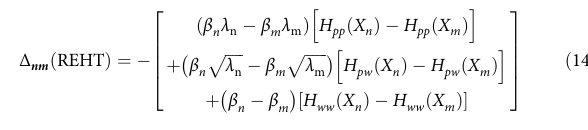
List of systems studied and preparation of atomistic model . Figure 1 and Supplementary Table 1 contain information about the diverse sets of proteins used in this work. The initial unfolded structure of Trp-Cage and β -hairpin (C terminal hairpin of B1 domain in protein G) were obtained by simulating the corresponding folded NMR structures (PDB ID: 1l2Y and 1lE3, respectively) at 600K temperature for 10ns. For His-5, the unfolded structure was built using VMD protein builder by feeding in the sequence information (DSHAKRHHGYKRKFHEKHHSHRGY). Simulation of RFA-H C-terminal domain was initiated from the α -helical conformation (PDB ID:2OUG). All the proteins (system 1 – 5 in Fig. 1) were solvated in a cubic box with a minimum distance of 1.2nm from the surface of the protein (in case of RFA-H 1.5nm is used). A 3-site rigid TIP3P water model was used for all the systems. The systems were also neutralized with physiological concentration of NaCl (0.15M). For the topological parameters of fast-folding proteins, we used Amberff14SB in order to faithfully compare the ef fi ciency with earlier REST2 and gREST simulations 16 , whereas for all the rest of the systems (alanine dipeptide, His-5 and RFA-H), Charmm36m 29 force fi eld was used. Details of MD simulation . The modeled proteins solutions were initially energy minimized using steepest descent algorithm for 50,000 steps to avoid any poor contacts. The minimized structure was then thermalized and equilibrated sequentially in NVT and NPT ensembles each for 2ns. The protein and the solvent were coupled separately to the target temperatures using a modi fi ed Berendsen thermostat. The pressure was set at 1bar using Parrinello-Rahman barostat. The fi nal production simulation was performed in NVT ensemble using Nose-Hoover thermostat. A cut-off of 1nm was used for calculating the electrostatics and VdW interactions. Particle Mesh Ewald was used for long-range electrostatics. Leap-frog integrator with a time step of 2fs was used to integrate the equations of motions. All the hydrogen atoms were constrained using LINCS algorithm. The simulations were performed using Gromacs-2016.5 patched with Plumed-2.4.1. All the para- meter fi les are available in the GitHub repository (https://doi.org/10.5281/ zenodo.4361714) 67 . Replica exchange parameters . For all the simulations, we ran both the REHT scheme designed in this work as well as the state-of-the-art REST2 method. The two methods differ in the way the protein and water molecules are treated in the Hamiltonian. REST2 tempers only the protein but keeps the water at room tem- perature by scaling the potential energy function of solute. The bath temperature used in REST2 is constant across all the replicas. On the other hand in REHT method, the bath temperature is raised mildly up to 340 K as we go up on the replica ladder. This suf fi ciently heats up the water molecules allowing for its ef fi - cient dynamics in REHT method. For enhancing the protein dynamics, the potentials of the protein solute are scaled up to a maximum factor ( λ ) of ~0.5. To ensure the faithful comparison, the overall effective temperature realized on the protein is identical in both the simulations (Supplementary Table 1). However, due to the extra degrees of freedom due to treatment of the water, the number of replicas used is moderately higher for the REHT method than for the REST simulations. More details and the scripts for all the input preparation (including the scaling of Amber14SB and charmm36m force fi elds) are given in the github link: